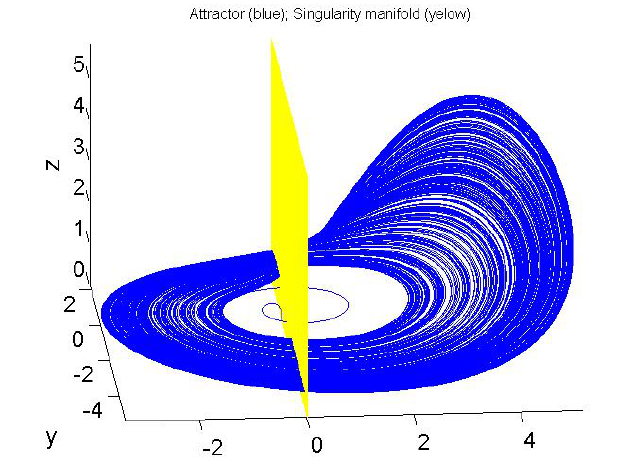
x is selected as output. O (yellow) when